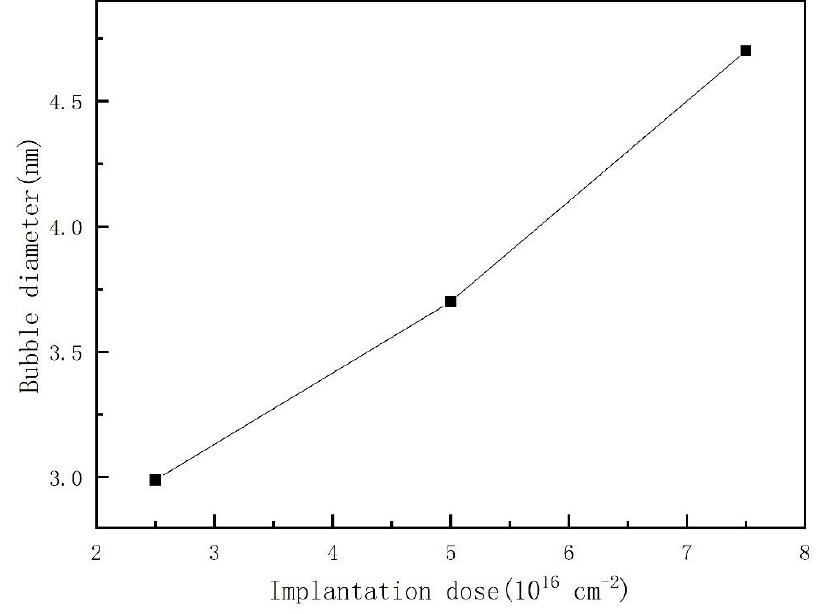
Figure 5. The relationship between the average diameter of helium bubbles and the helium ion implantation dose (helium ion implantation temperature of 180 ◦ C and helium ion of 100